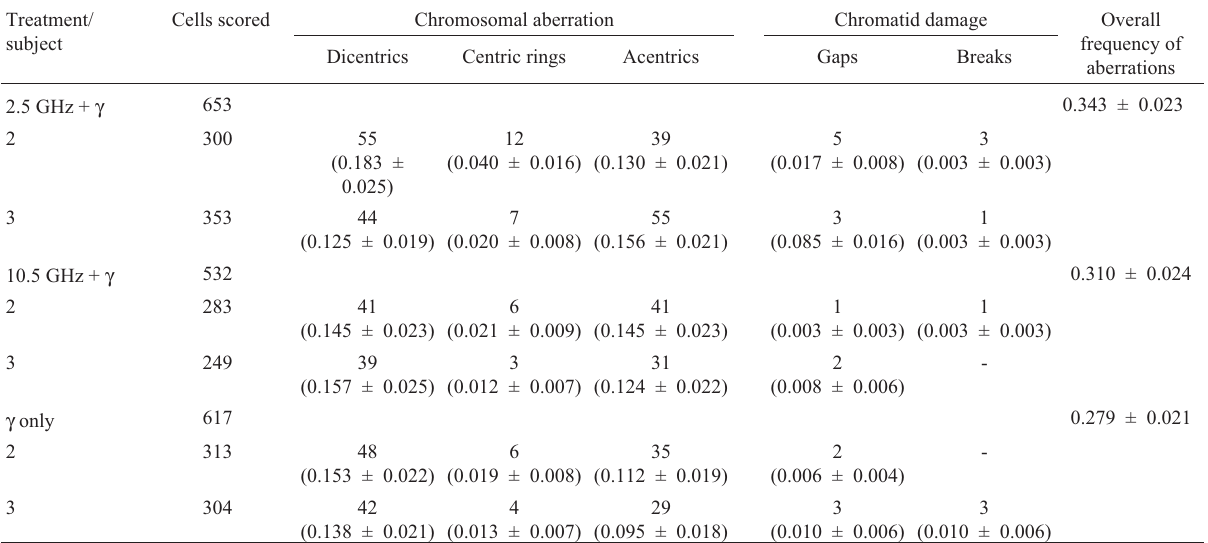
Table3 -Numberandfrequenciesofstructuralchromosomalaberrationsinhumanlymphocytesexposedtomicrowavefieldsandsubsequentlyto1.5Gy of gamma radiation.